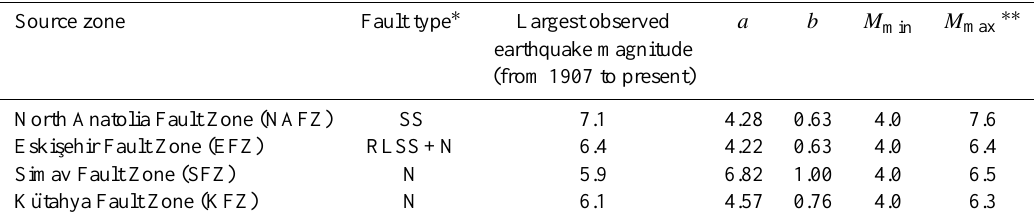
Table 2. Seismic hazard parameters used in this study.